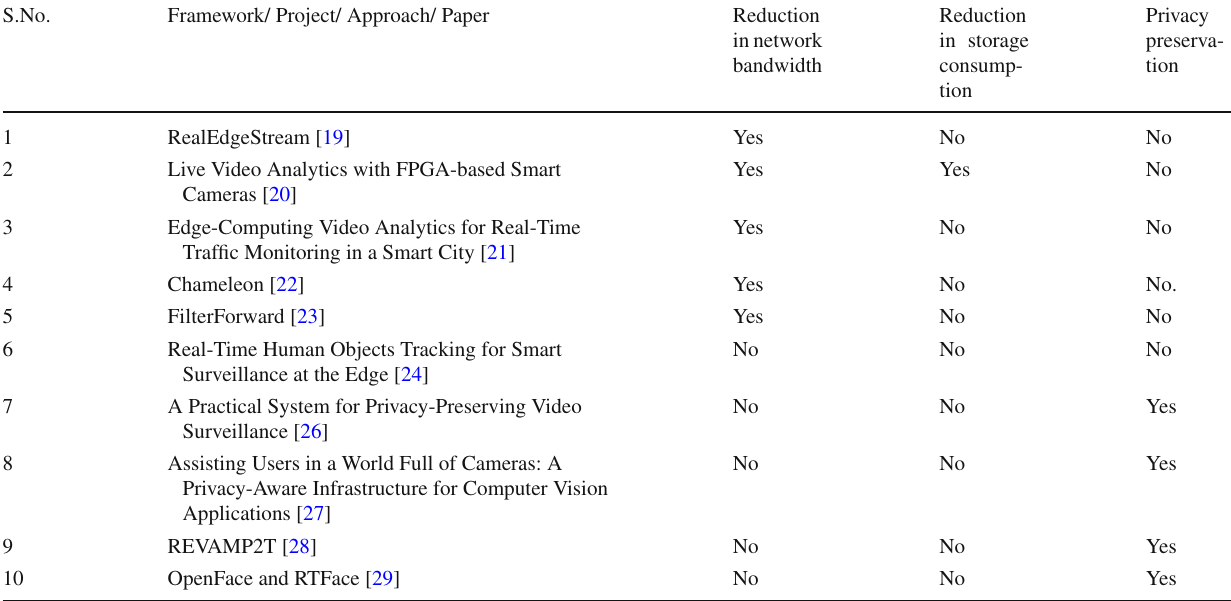
Table 1 Existing video-surveillance frameworks – optimization and privacy assurance evaluation